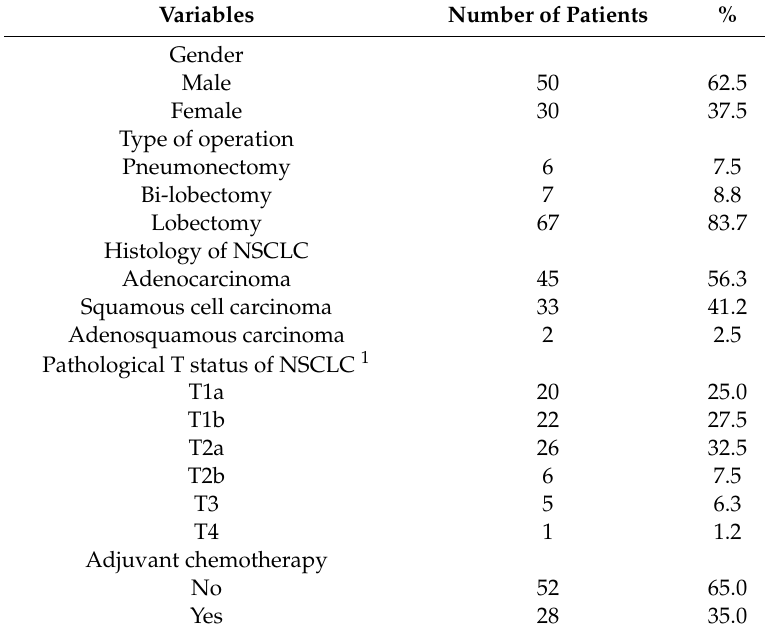
Table 1. Characteristics of 80 patients with non-small cell lung carcinoma (NSCLC). Variables